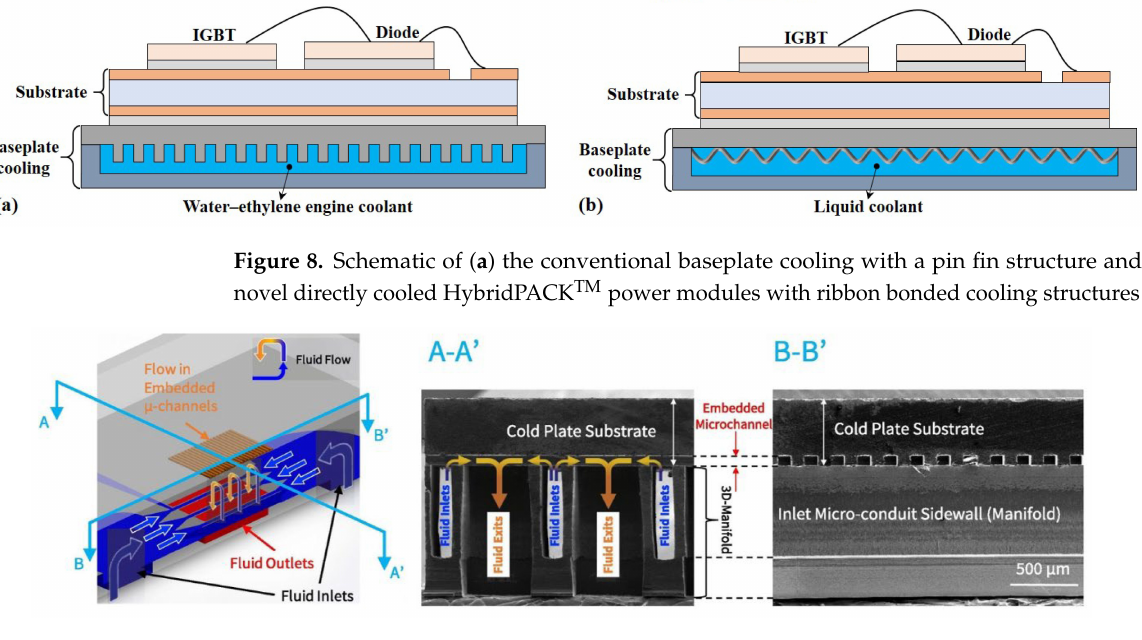
Figure 9. Conceptual design of the embedded Si/SiC microchannel cooling with a 3D manifold structure